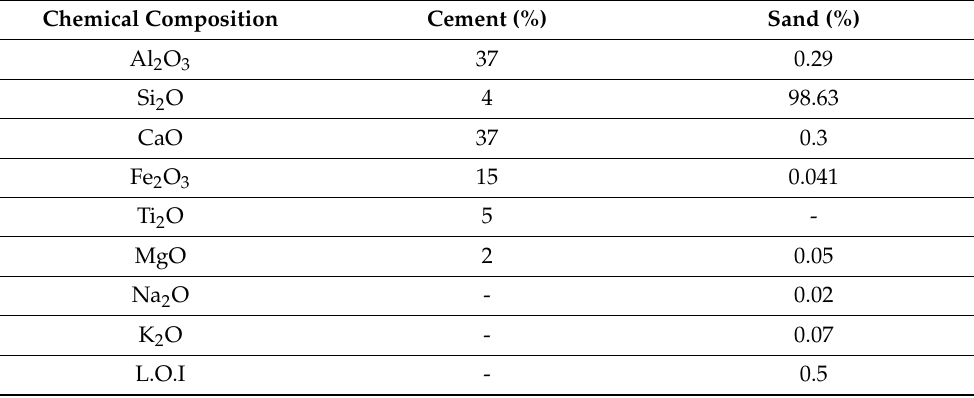
Table 2. Chemical compositions of cement mortar media.